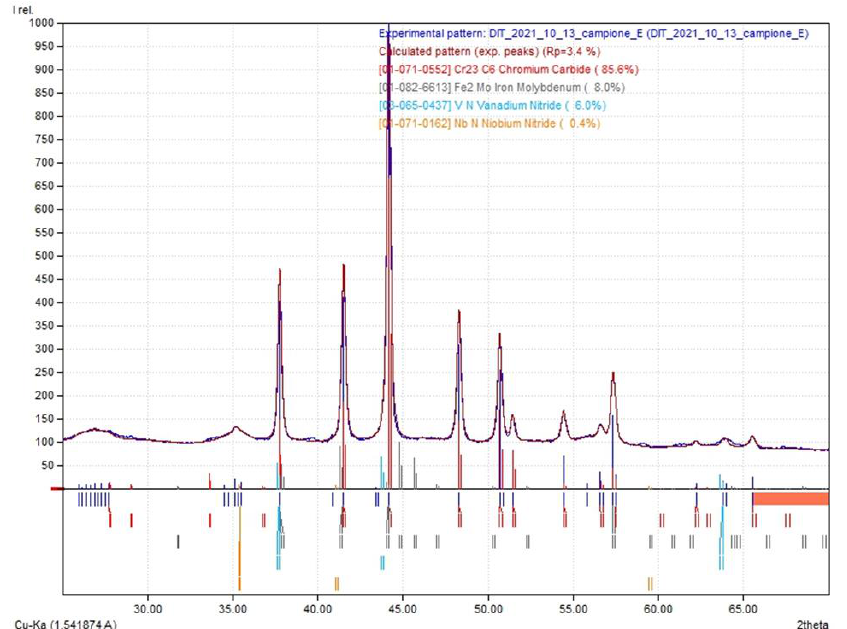
Figure 14. Exposed material specimen 92-EX-1-2 (92 BM 604 °C 43 MPa 74,001 h) (sample E), XRD analysis.